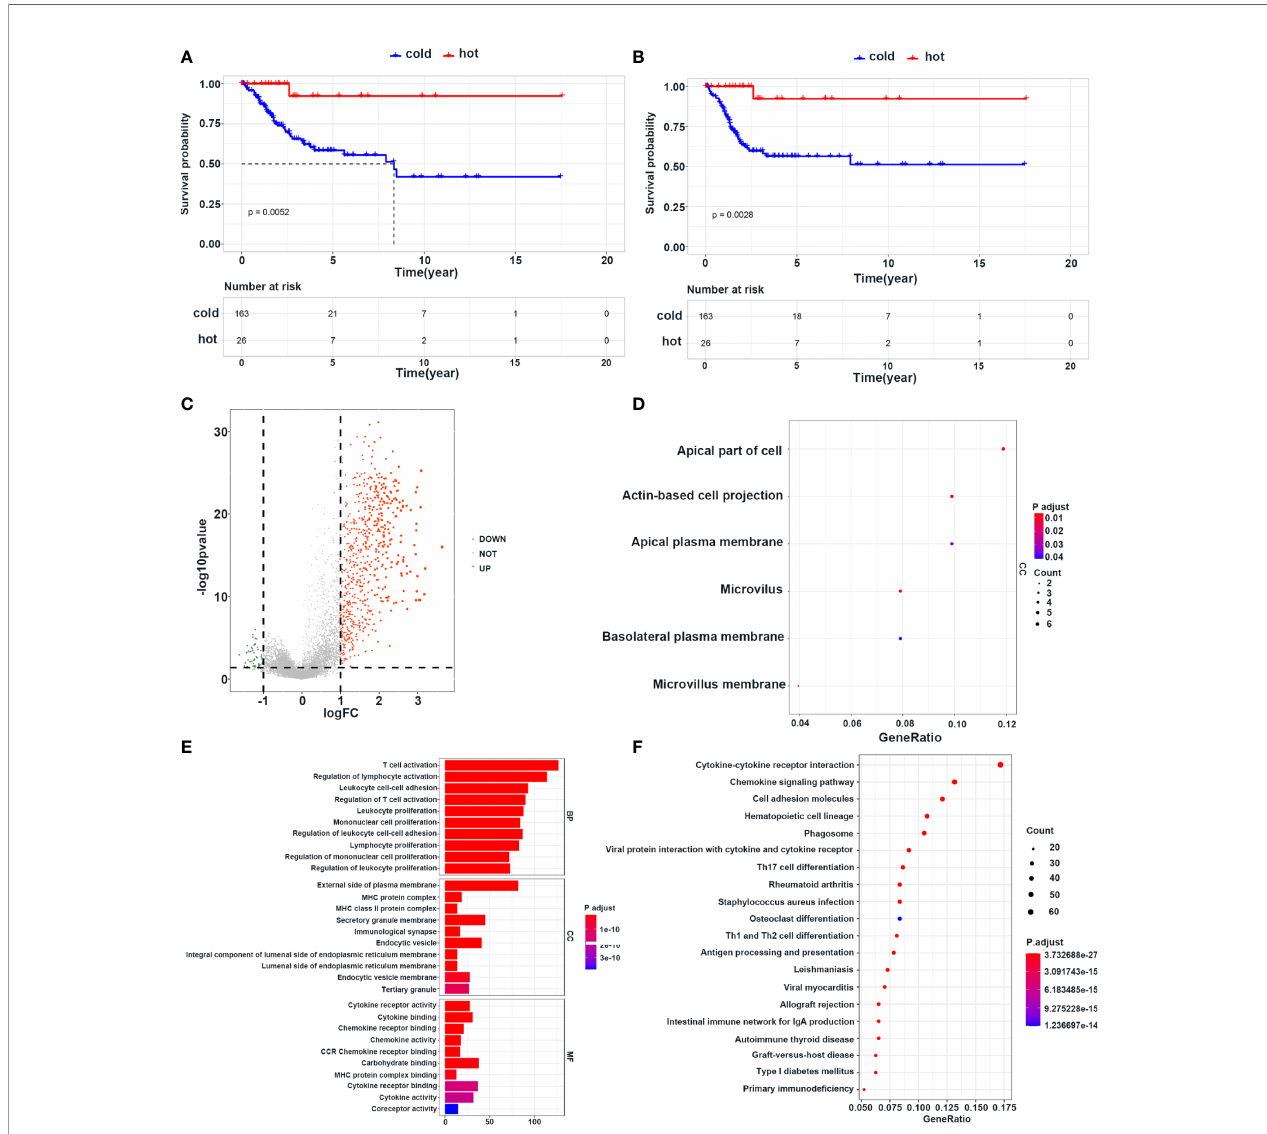
FIGURE 5 | Survival and transcriptome characteristics of cold and hot tumors. (A, B) Kaplan – Meier curve shows the OS and PFI of cold and hot tumors. (C) Volcano plot shows the difference of gene expression in cold and hot tumors. (D) GO enrichment analysis in cold tumors. (E) GO enrichment analysis in hot tumors. (F) KEGG enrichment analysis in hot